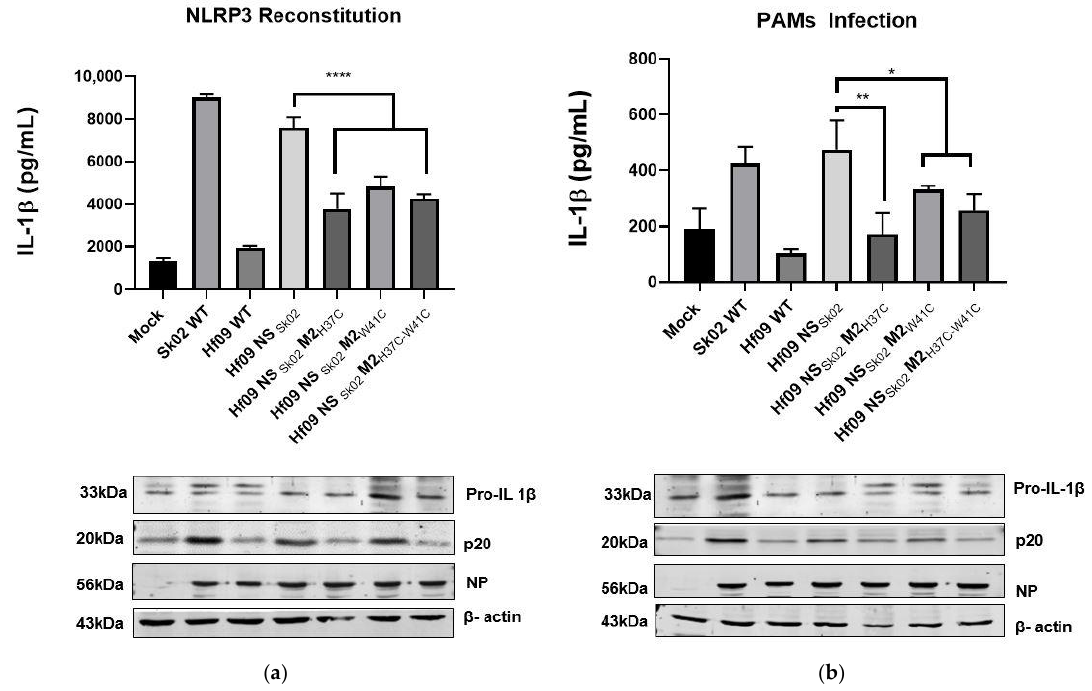
Figure 7. His37 and Trp41 in M2 affect IL-1β production. ( a ) HEK293T cells were transfected with different combinations of plasmids expressing porcine NLRP3, ASC, pro-caspase-1, and pro-IL-1 β . At 12 h.p.t., the cells were mock-infected or infected with the viruses as indicated at an MOI of 5. Porcine IL-1β from the cell-free supernatants at 12 h.p.i. was measured by ELISA. The expression of pro-IL-1β, the active caspase-1, p20, NP, and β-actin was measured by Western blotting in the cell lysates ( t -test, **** p < 0.0001). ( b ) PAMs were infected with various viruses as indicated at an MOI of 1 for 24 h. The cell-free supernatant was collected to measure the IL-1β level by ELISA and the cell pellet was lysed and checked for the level of pro-IL-1β, p20, NP, and β-actin by Western blotting ( t -test, ** p = 0.0033; * p = 0.0339).